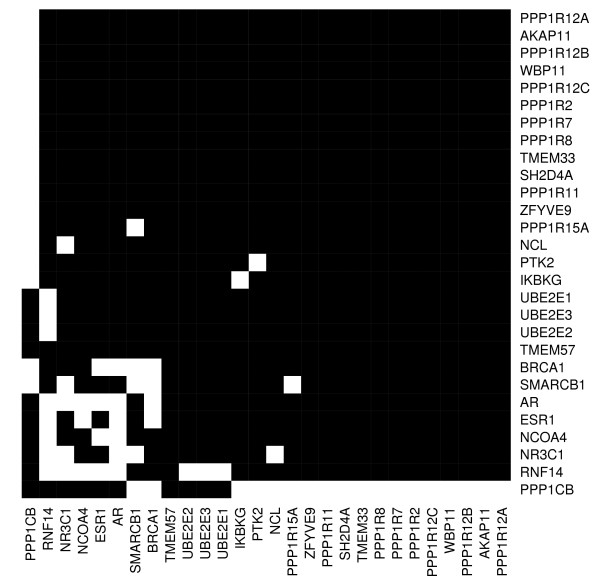
Protein-protein interaction adjacency matrix. Protein-protein interaction adjacency matrix for all the protein-protein interactors of PPP 1CB, RNF14, TMEM57. Protein names appear as columns and row names, direct interaction are shown in white.